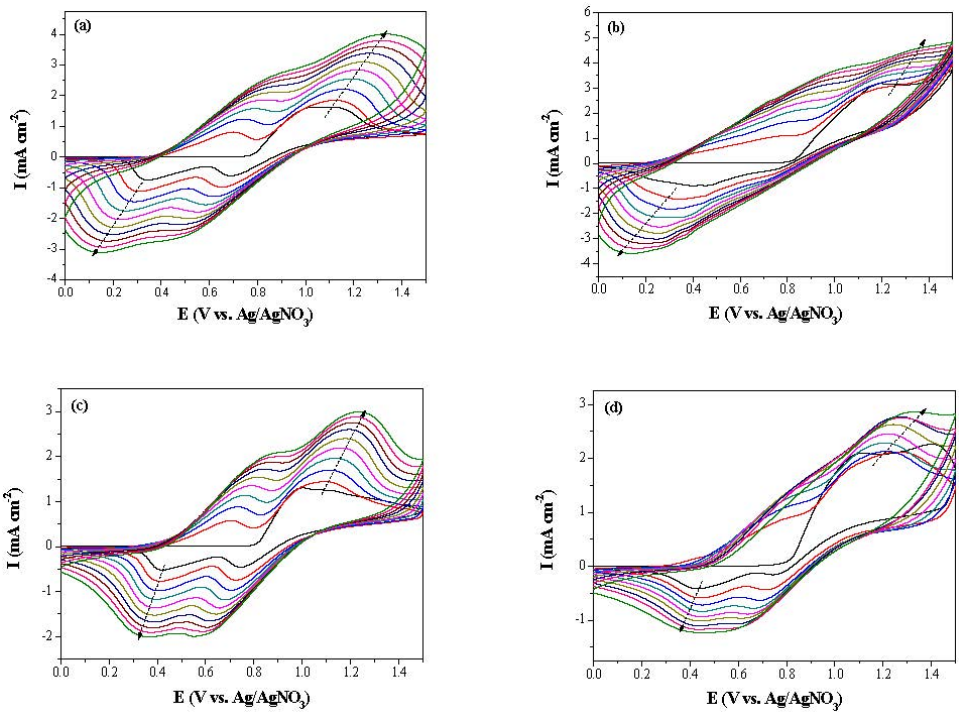
Figure 3. Electrochemical synthesis of ( a ) PbCmB, ( b ) P(bCmB- co -bTP), ( c ) P(bCmB- co -dbBT), and ( d ) P(bCmB- co -TF) in an ACN/DCM (1:1 by volume) solution at 100 mV s − 1 on ITO glass.